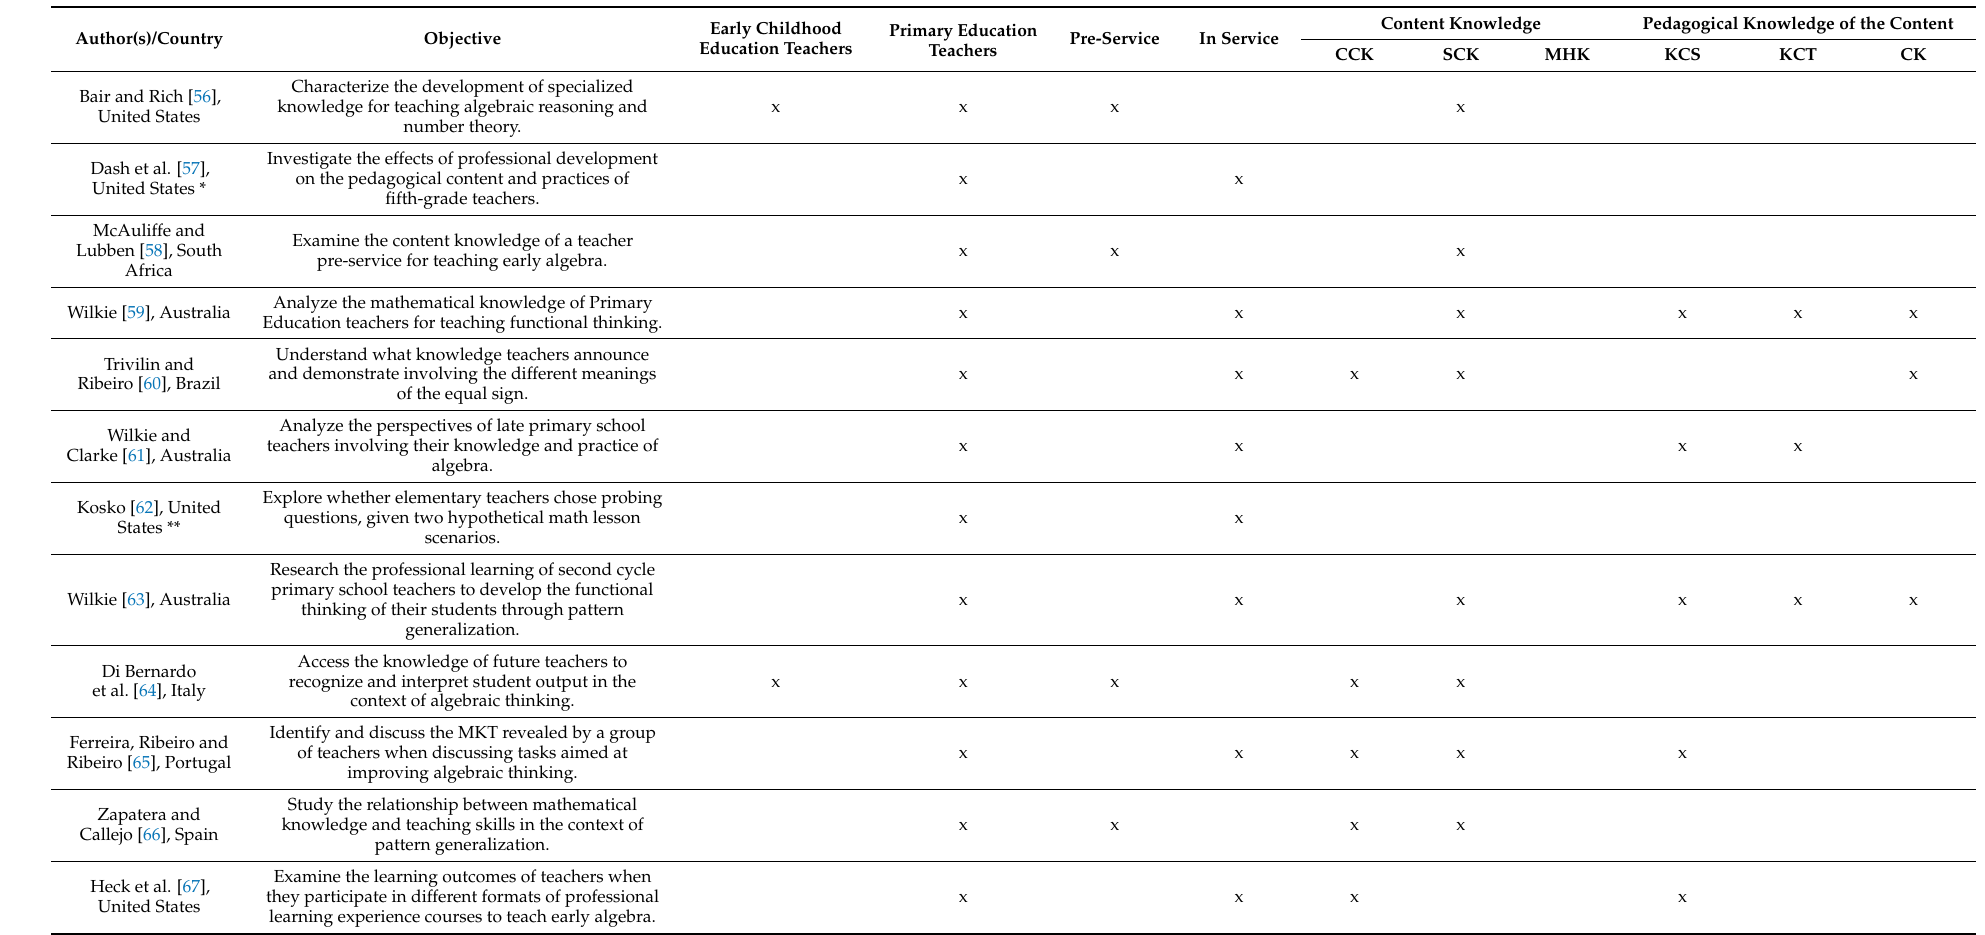
Table 2. Categorization of the papers (2010–2021) on the MKT for teaching early